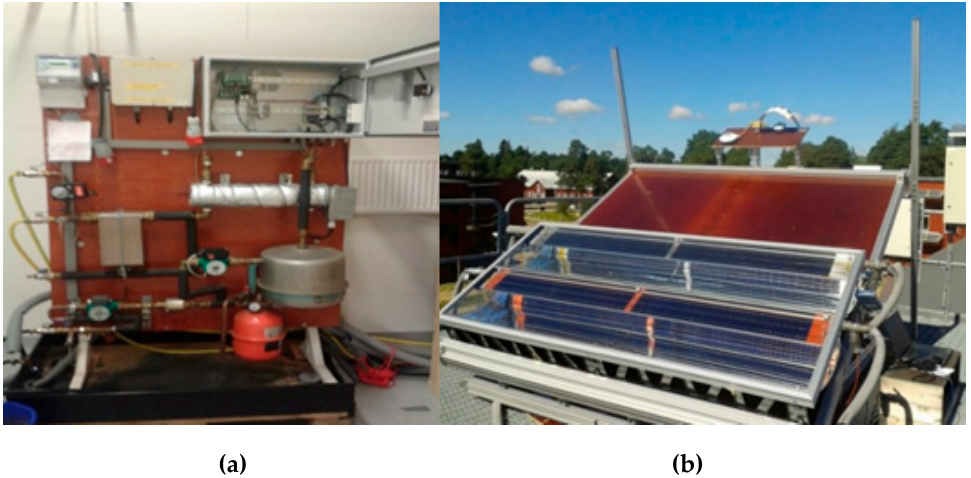
Figure 7. ( a ) Solar Collector Test Rig at Gävle University. ( b ) The tested Solarus CPVT collector